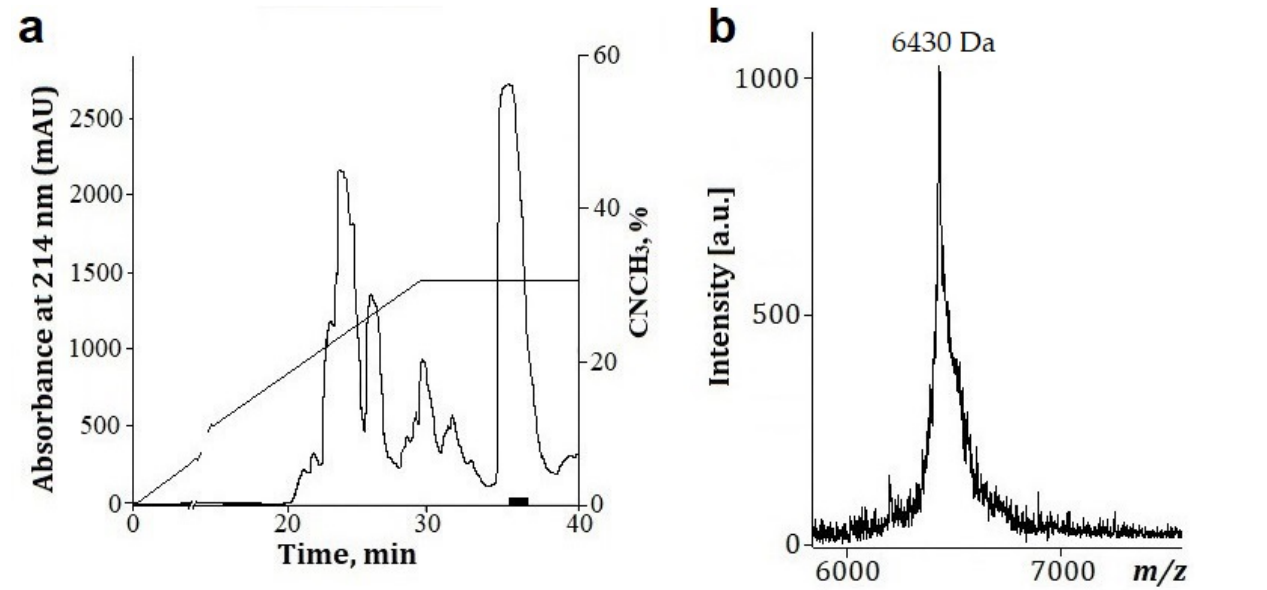
Figure 2. Isolation and molecular mass of HCIQ1c9: ( a ) HPLC elution profile of HCIQ1c9 on a Jupiter C4 reverse-phase column (10 × 250 mm), using a linear gradient of acetonitrile concentrations (0–70%) over 70 min with 0.1% TFA and a flow rate of 1.5 ml/min; ( b ) MALDI-TOF MS spectrum of HCIQ1c9 after